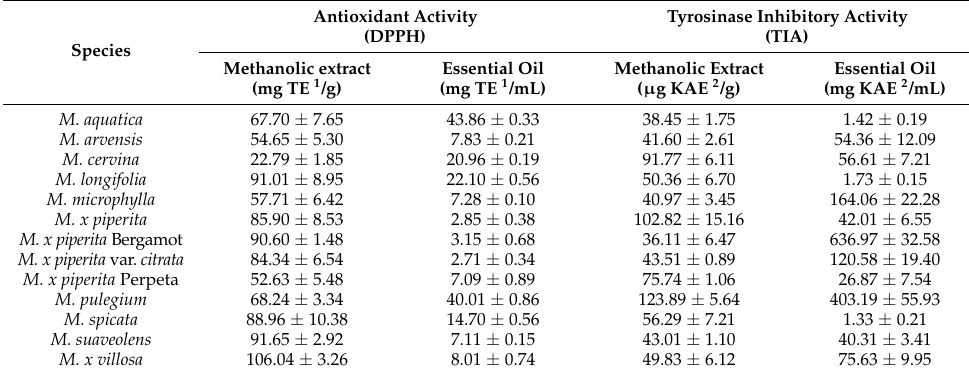
Table 2. Antioxidant and tyrosinase inhibitory activities of selected Mentha sp.